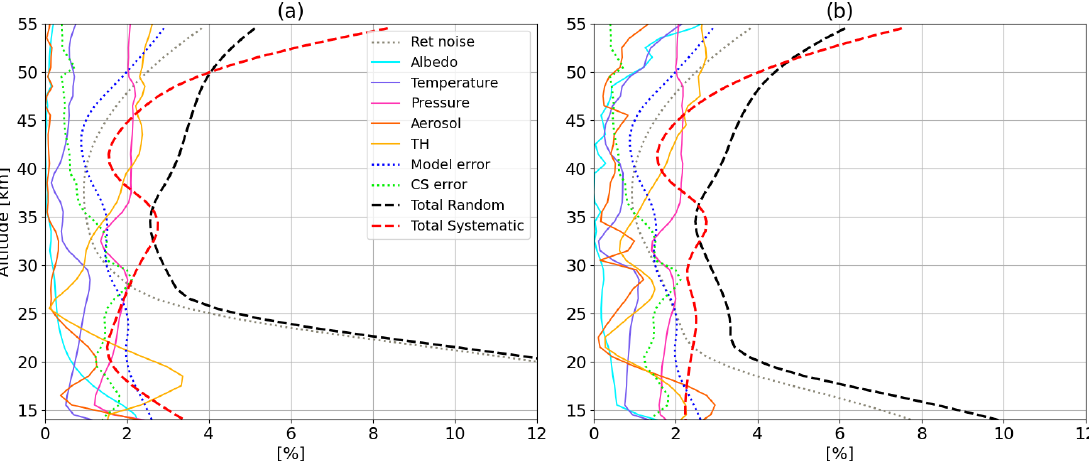
Figure 12. Contributions to the total uncertainty on ozone profiles in the tropics (a) and at high latitudes (b) in summer. The total random uncertainty is reported with the dashed black line, whereas the estimated systematic bias is shown with the red dashed line.